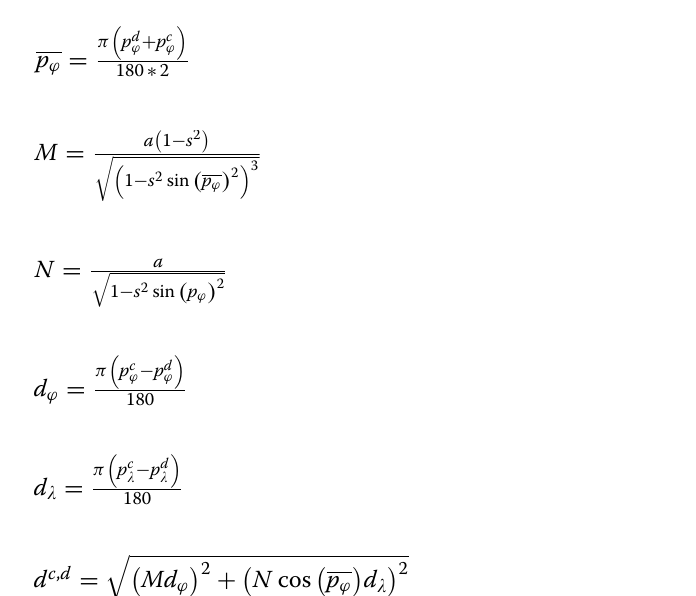
Hubeny distance Hubeny distance is a formula to calculate the distance between a geodetic coordinate in an earth model. The formula is stated below: